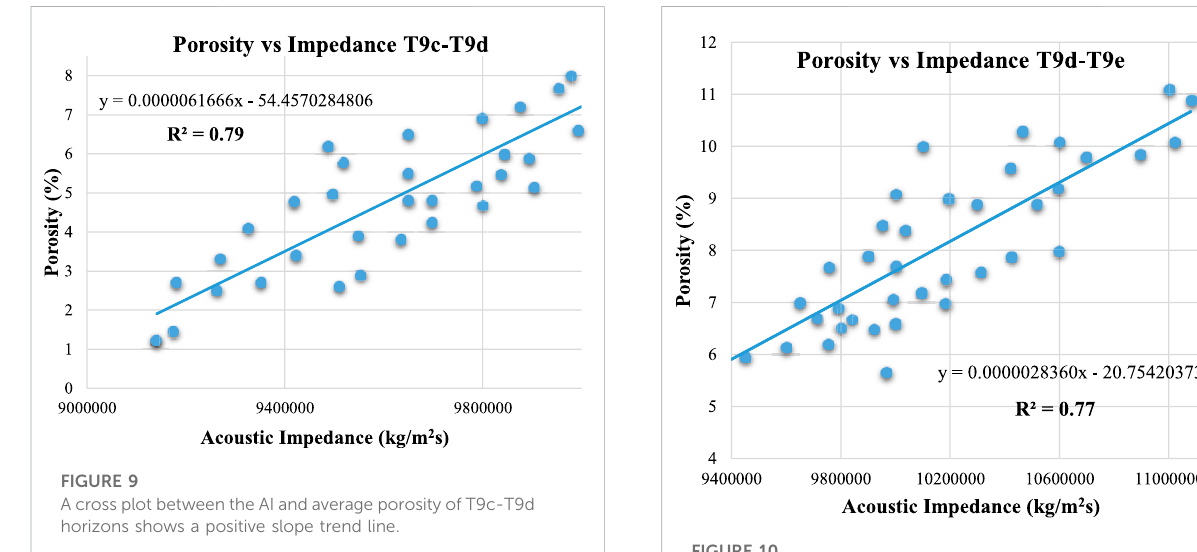
FIGURE 10 A cross plot between the AI and average porosity of T9d-T9e horizons shows a positive slope trend